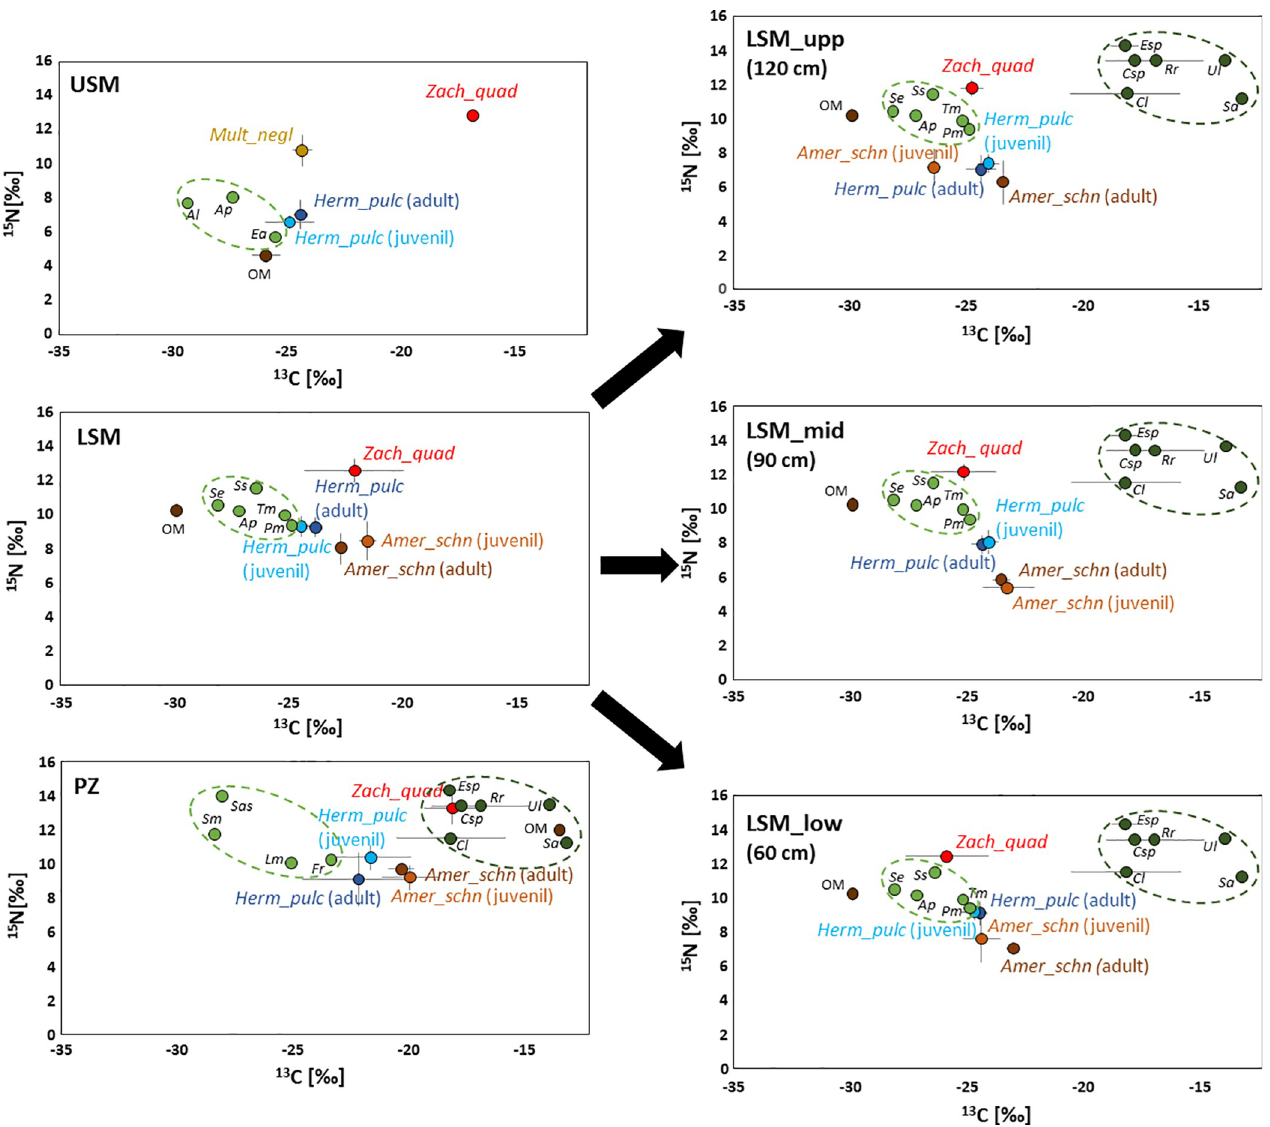
Fig 5. Stable isotope values ( δ 13 C [‰] and δ 15 N [‰]) (means ± SD) of Multioppia neglecta (Mult_negl; yellow), Hermannia pulchella (Herm_pulc; blue) (adults and juveniles), Zachvatkinibates quadrivertex (Zach_quad; red), Ameronothrus schneideri (Amer_schn; brown) (adults and juveniles) at different salt marsh zones [upper salt marsh (USM), lower salt marsh (LSM), pioneer zone (PZ)] and artificial island heights [LSM_upp (120 cm), LSM_mid (90 cm), LSM_low (60 cm)]. Dotted ellipses in light green (drawn by eye) mark C3 plants (Al- Atriplex littoralis , Ap- Atriplex prostrata and Atriplex portulacoides , Ea- Elymus athericus , Pm- Puccinellia maritima , Se- Salicornia europaea , Ss- Spergularia salina , Tm- Triglochin maritima , Fv- Fucus vesiculosus , Lv- Limonium vulgare , Sas- Salicornia stricta and Sm- Suaeda maritima ) and in dark green C4 plants and algae (Csp- Ceramium sp ., Cl- Chaetomorpha linum , Esp- Enteromorpha sp ., Rr- Rhizoclonium riparium , Sa- Spartina anglica and Ul- Ulva lactuca ); org. mat., organic matter (dark brown). Black arrows from the LSM to the three artificial island heights indicate the vegetation zone where soil, plants and species originated